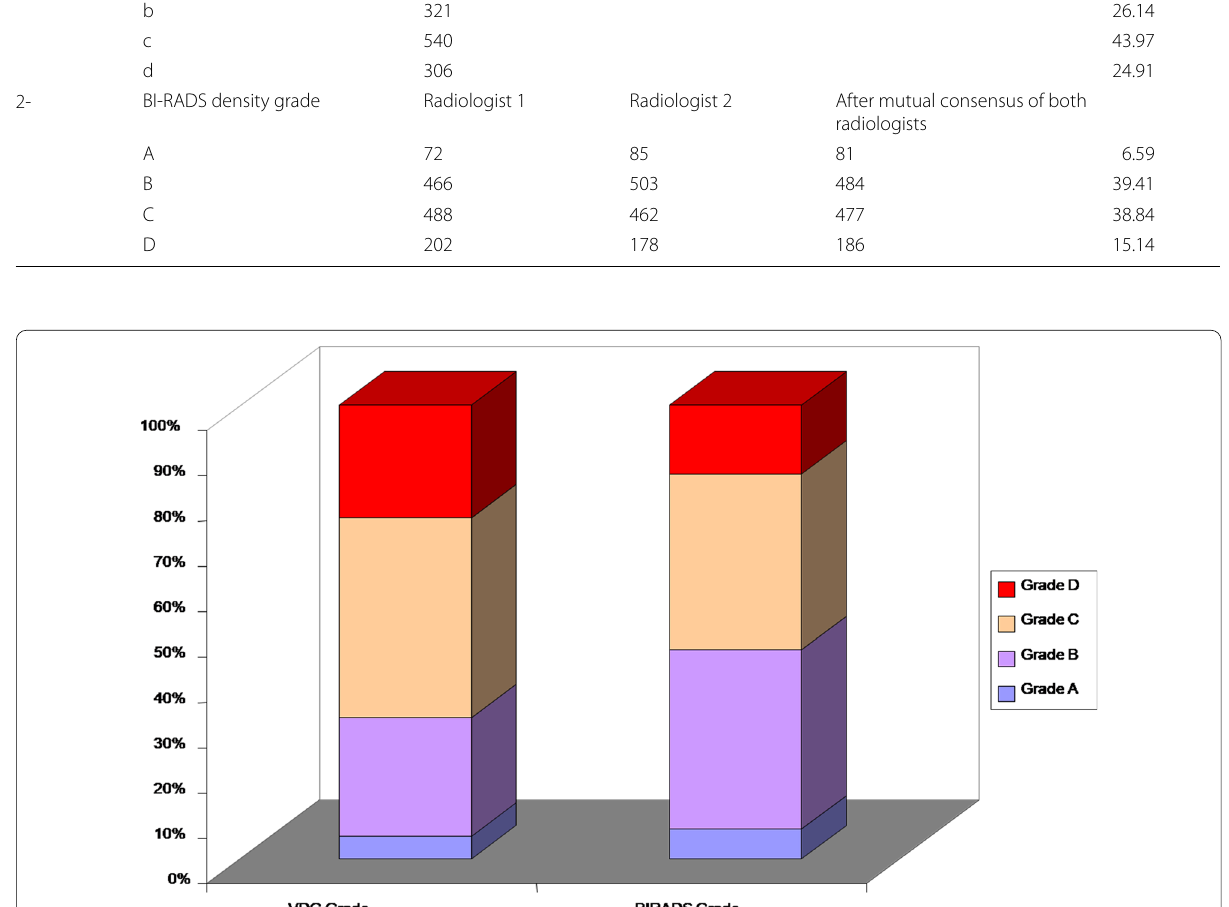
Fig. 3 Bar chart shows comparison of the distribution of different volumetric density grades and BIRADS density grades in study